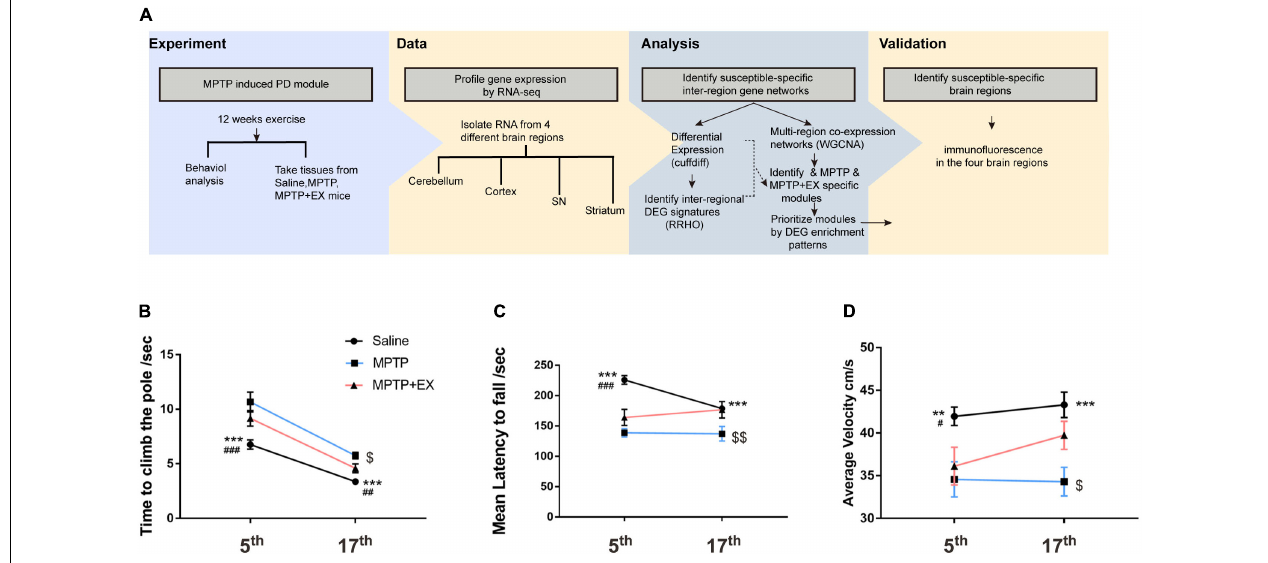
FIGURE 1 | Motor function recovery in mice treated with MPTP after the 12-week treadmill exercise. (A) Scheme of the experimental design. (B) Time spent in descending to the floor for the saline ( n = 24), MPTP ( n = 12), and MPTP + EX ( n = 12) groups. (C) Time spent in the rotarod for the saline ( n = 24), MPTP ( n = 12), and MPTP + EX ( n = 12) groups. (D) Average speed in the open field for the saline ( n = 24), MPTP ( n = 13), and MPTP + EX ( n = 13) groups. Data are mean ± s.e.m. Statistical analysis is performed using mixed-model ANOVA followed by the LSD post hoc test. ** p < 0.01, saline vs. MPTP; *** P < 0.001, saline vs. MPTP; # p < 0.05, saline vs. MPTP + EX; ### p < 0.001, saline vs. MPTP + EX; $ p < 0.05, MPTP vs. MPTP + EX; $$ p < 0.01, MPTP vs. MPTP +